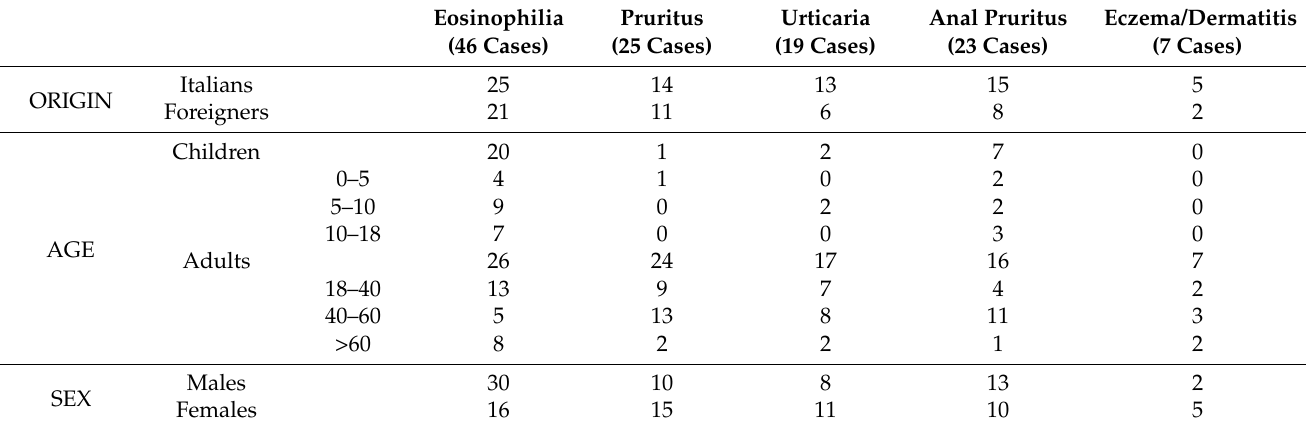
Table 4. Statistical analysis concerning the association between the most frequent clinical signs other than the gastrointestinal-related ones and dientamoebiasis for each demographic